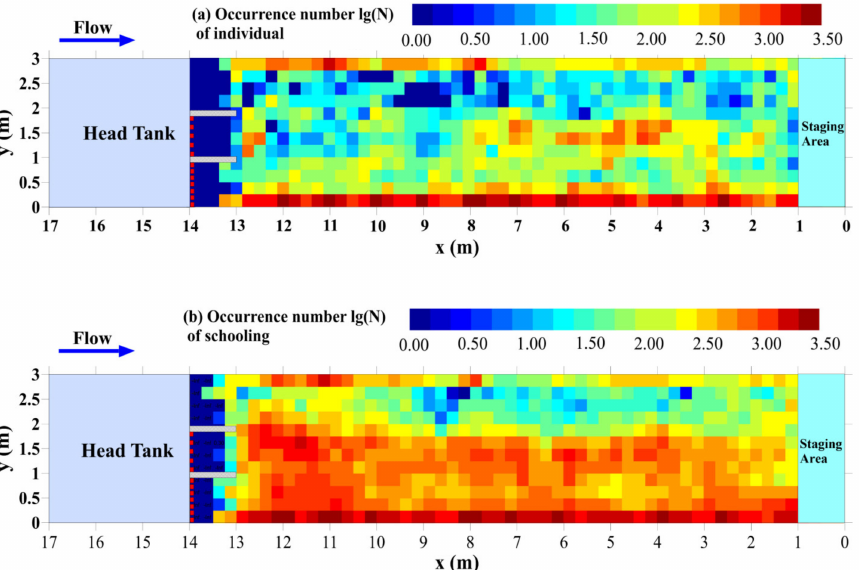
Figure 6. Heatmaps of individual S. prenanti and schooling in each cell ( 0.25 × 0.25 m ) of the swim test area in the open-channel flume. ( a ) occurrence number lg(N) of individual and ( b ) Occurrence number lg(N) of